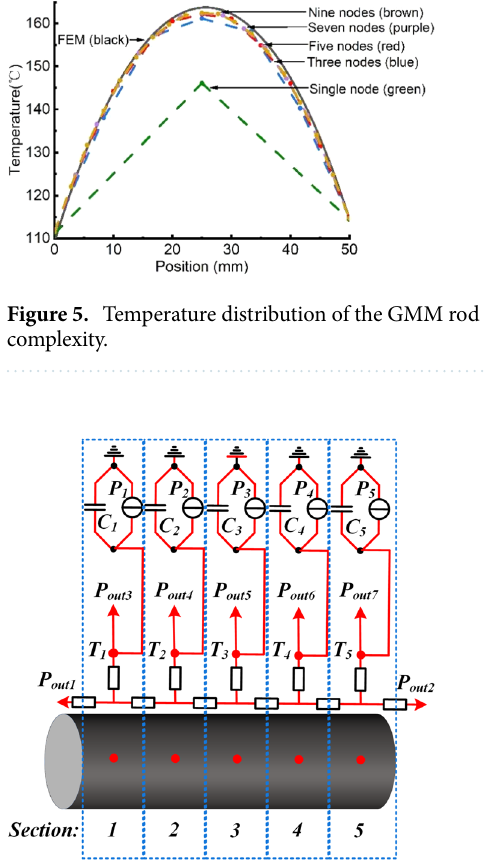
Figure 6. Equivalent thermal circuit with 5 nodes for the GMM rod in the